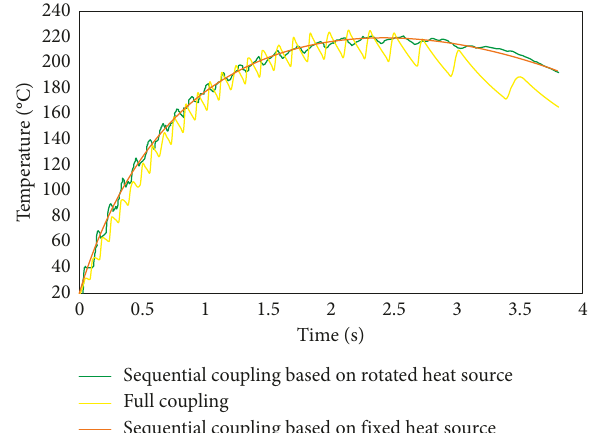
Figure 13: Comparison of three simulation methods for the temperature rise